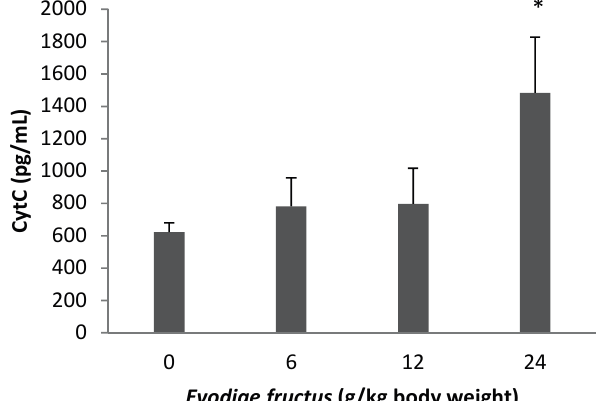
Figure 8. Effects of aqueous extract of EF on CytC release. The concentrations of CytC in endochylema of different groups were showed. Data were presented as mean ± SEM (n = 10). Compared with control group * p <